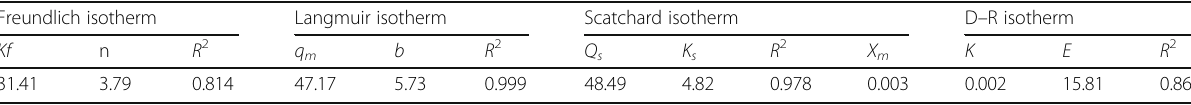
Table 1 Equilibrium isotherm model parameters Freundlich isotherm Langmuir isotherm Scatchard isotherm